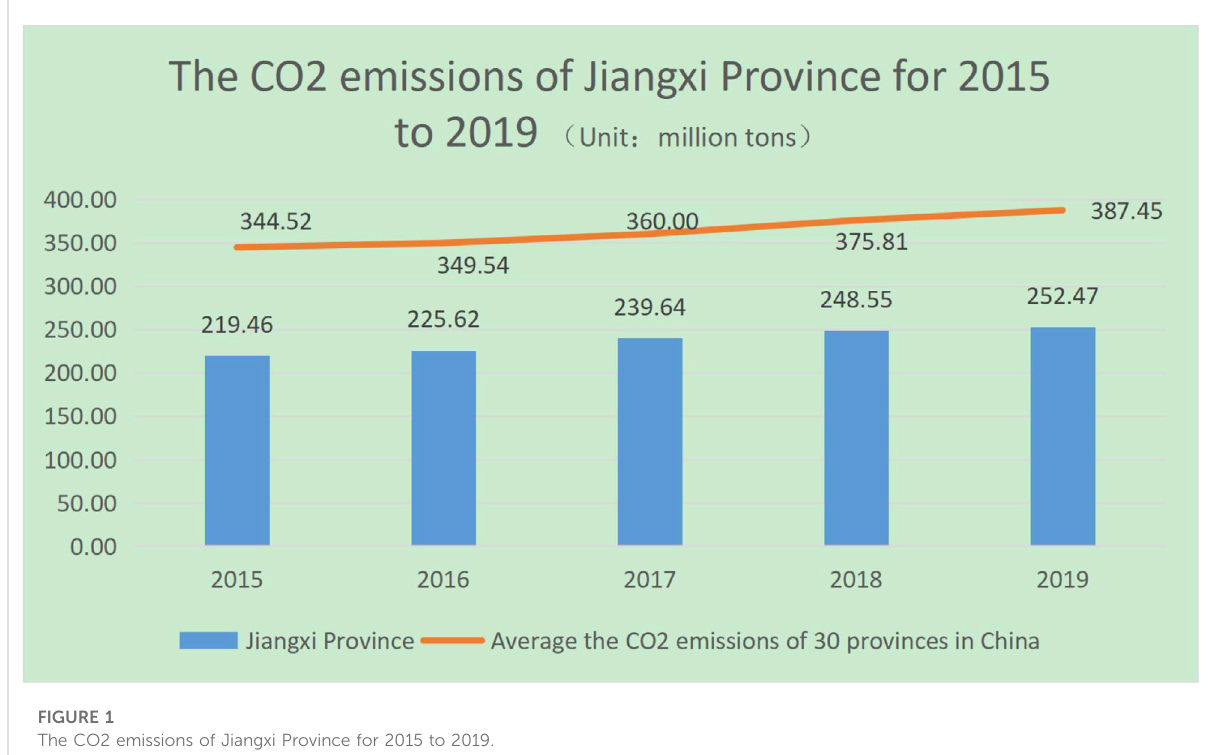
FIGURE 1 The CO2 emissions of Jiangxi Province for 2015 to 2019.